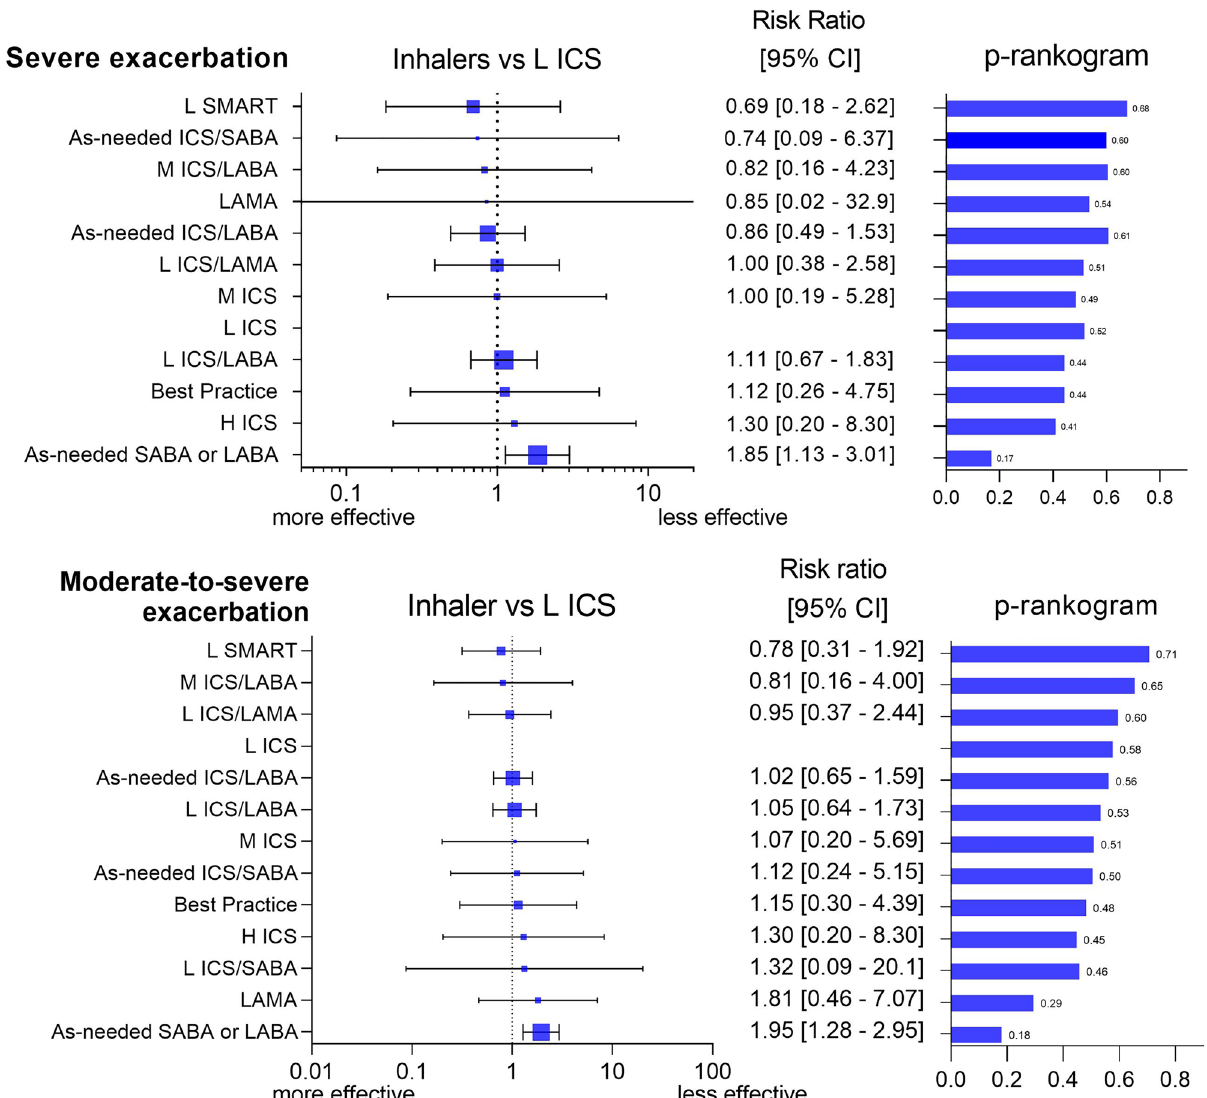
Figure 3. Forest plot and p-rankogram of all therapies for severe and moderate-to-severe exacerbation. Each inhaler therapy is compared with low-dose inhaled corticosteroid as maintenance. A high score in p-rankogram indicates a more potent and reliable treatment. See Fig. 2 for